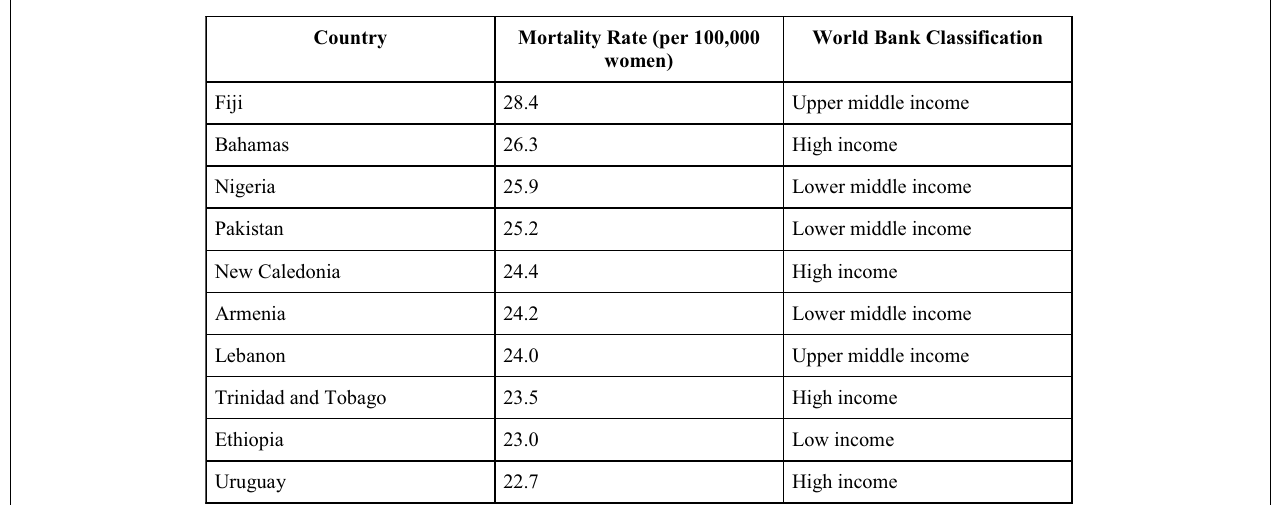
FIGURE 1 |Age-standardized mortality rates, number of deaths per 100,000 women (1)